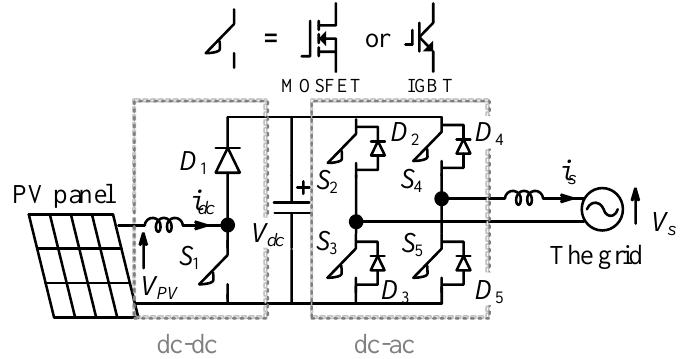
Table 1. Semiconductor power loss.